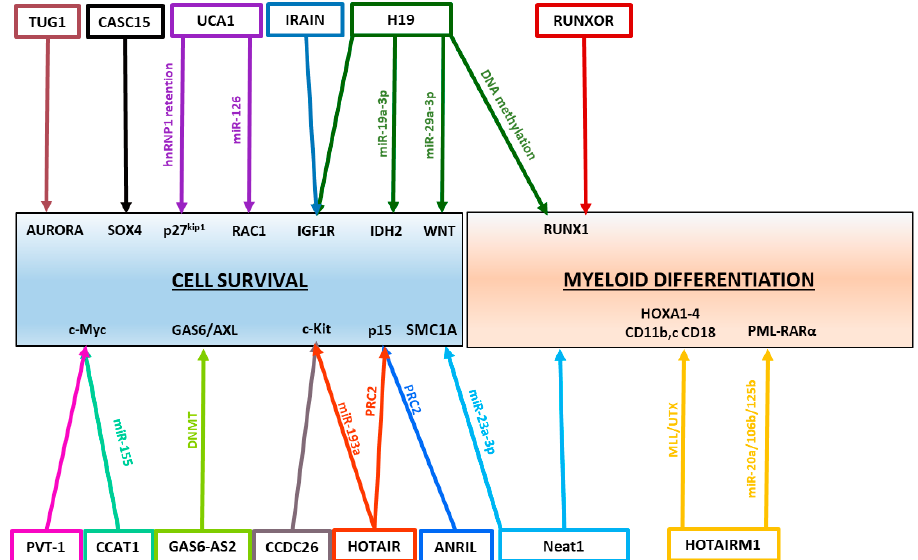
Figure 2. LncRNAs control cell survival and myeloid di ff erentiation leading to AML